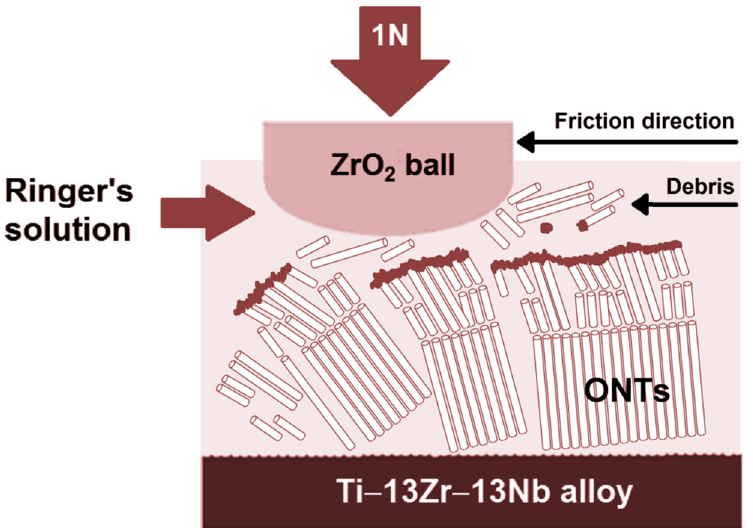
Figure 12. Three-body abrasion wear mechanism of the Ti–13Zr–13Nb alloy before and after anodizing in Ringer’s solution.